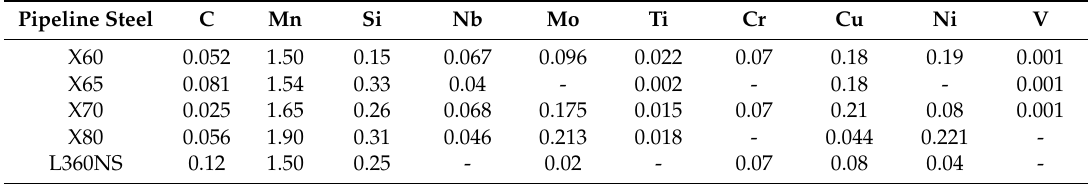
Table 1. Chemical composition of API X60, X65, X70, X80 and L360NS pipeline steel (wt. %) [7–9]. Pipeline Steel